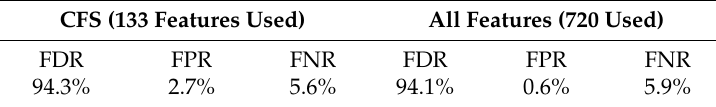
Table 1. Performance of proposed system in fault sound